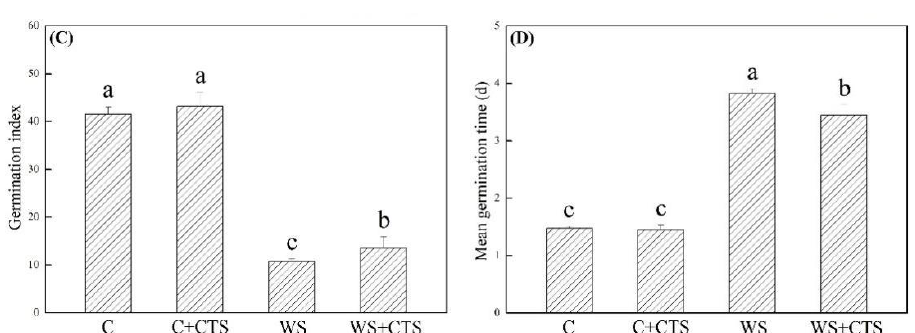
Figure 1. Seeds priming with chitosan affected ( A ) germination percentage, ( B ) germination vigor, ( C ) germination index, and ( D ) mean germination time under water stress. Vertical bars above columns indicate ± SE of mean, and different letters above columns indicate significant difference ( p < 0.05). C, control (seeds pretreated with H 2 O germinated under normal condition); C+CTS, control + CTS (seeds pretreated with CTS germinated under normal condition); WS, water stress (seeds pretreated with H 2 O germinated under water stress condition); WS+CTS, water stress + CTS (seeds pretreated with CTS germinated under water stress condition).